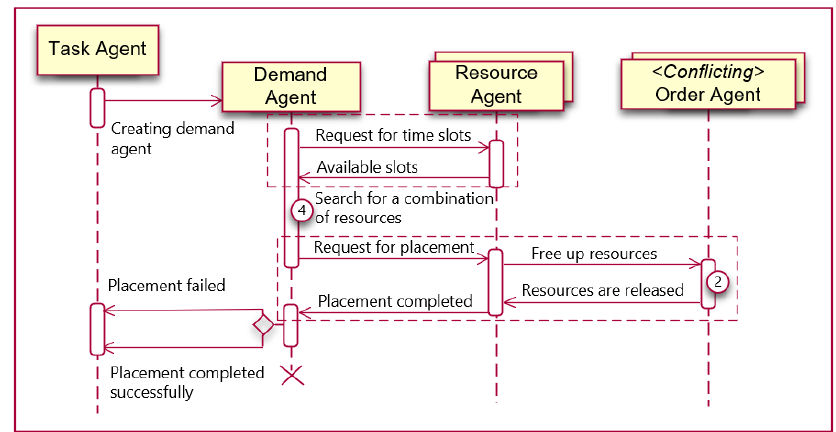
Figure 4. Fragment of negotiations of demand agent.